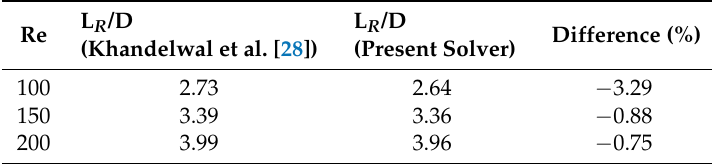
Table 4. Comparison of the recirculation lengths with the results of Khandelwal et al.